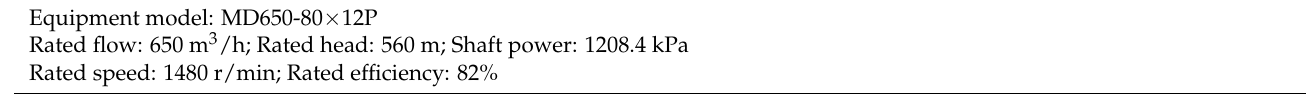
Table 5. Hydraulic performance data of MD650-80 × 12P self-balancing multistage